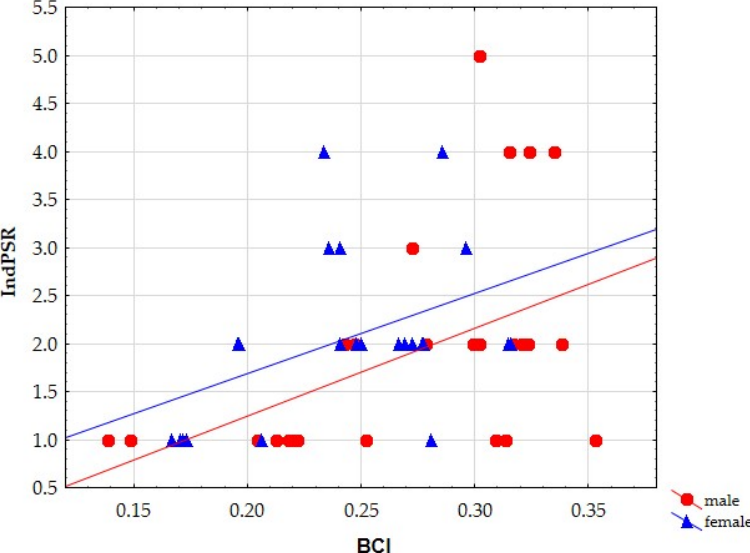
Figure 2. The relationship between individual parasite species richness (IndPSR) and body condi- tion index (BCI) in males and females of the yellow-necked mouse A. flavicollis.